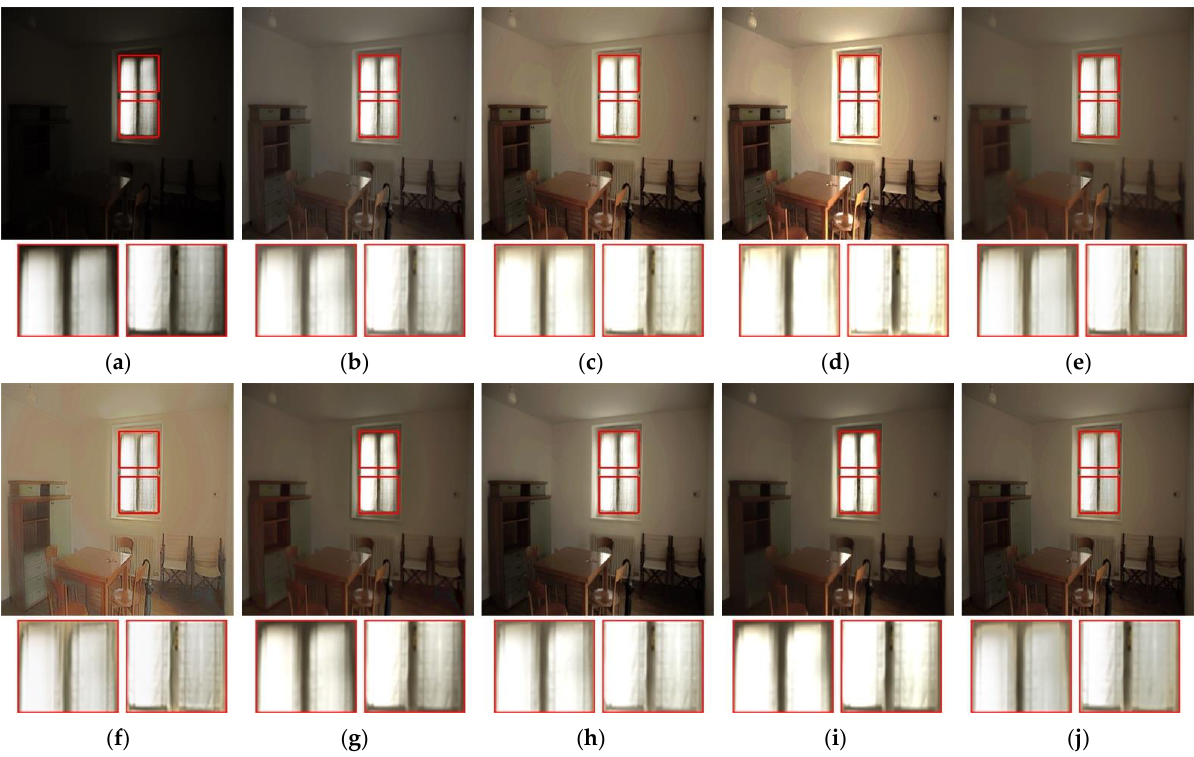
Figure 20. Enhanced results of “Window Curtain” image. ( a ) Original image; ( b ) BIMEF; ( c ) MEF;